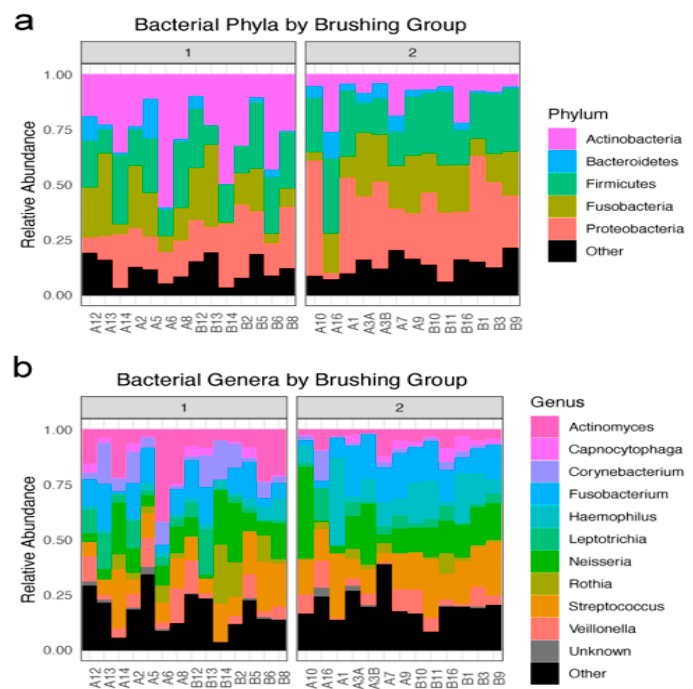
Figure 1. Overview of identified bacterial taxa: ( a ) Bacteria phyla by tooth brushing groups: brush1: once a day; brush2: twice a day. Relative abundance of the top five phyla, with an “other” group, in each participant sample within each tooth brushing group. ( b ) Bacterial genera by tooth brushing groups: brush1: once a day; brush2: twice a day. Relative abundance of the top 10 genera, with “other” and unknown groups, in each participant sample within each tooth brushing